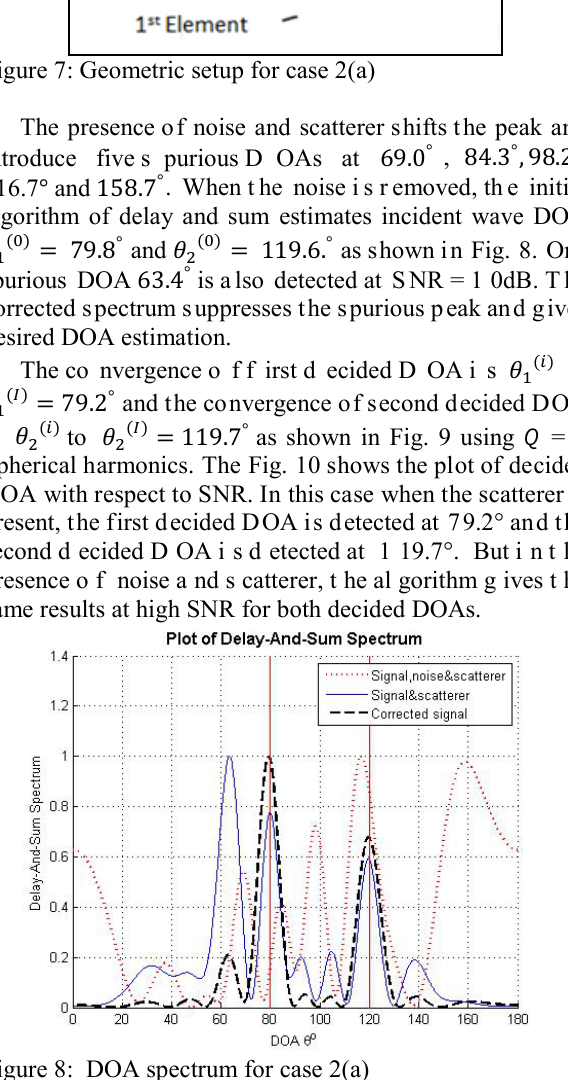
Figure 5: Convergence of decided